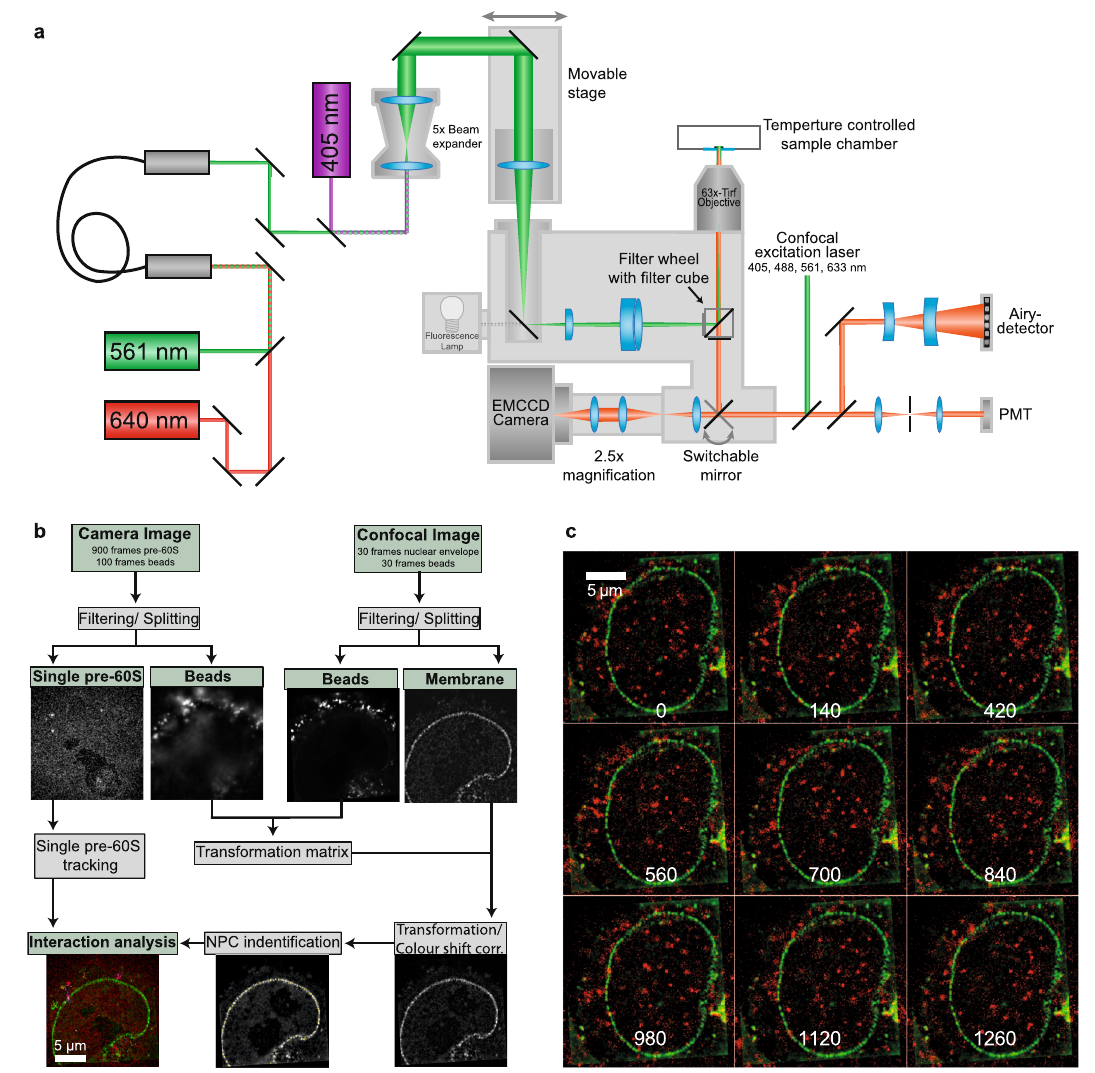
Fig. 2 Single-molecule and super-resolution confocal microscopy of the same cell. a A Zeiss LSM880 was extended by an additional beam path for narrow- fi eld single-molecule excitation and high sensitivity detection. This beam path was used for imaging single pre-60S particles labelled by eIF6- HaloTag-JF549 (red). By switching the fully automated microscope to confocal super-resolution mode we were able to image the very same sample region by Airyscan microscopy, which revealed single NPCs lined up at the NE labelled by eGFP-NTF2 (green). For image registration, UV fl uorescent microbeads coupled to the cell surface, which were seen in both modes, were used. b Sketch of the measurement principle. Using laser illumination with a wavelength of 561 nm a movie of single eIF6-HaloTag-JF549 (red) inside a cell nucleus was acquired at a high frame rate. After movie acquisition illumination switched from 561 to 405 nm to acquire images of the reference beads. Subsequently, super-resolution imaging of the NPCs labelled by eGFP-NTF2 (green) and of the reference beads was achieved by Airyscan microscopy in the green and UV fl uorescence channels, respectively. The EMCCD movie was used to determine pre-60S particle tracks in the nucleus and across the NE. The super-resolution images of the NTF2-labelled NPCs were employed to identify single NPCs and their positions along the NE. The two sets of the reference bead images were used to calculate the transformation matrix that was needed to map the pre-60S trajectories onto the NPC positions. c Hela cells stably expressing NTF2-eGFP (green) and eIF6-HaloTag labelled by JF549 (red) after image registration. Single pre-60S particles could be discerned. Numbers represent time in